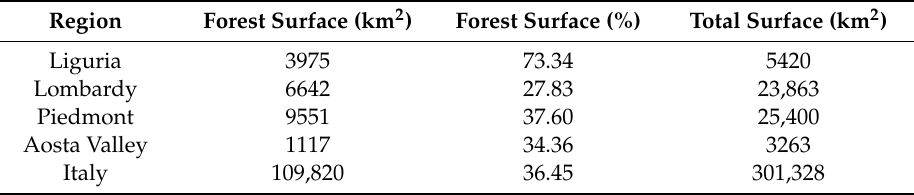
Table 1. Distribution of forests in Northwest Italy, 2015 projections